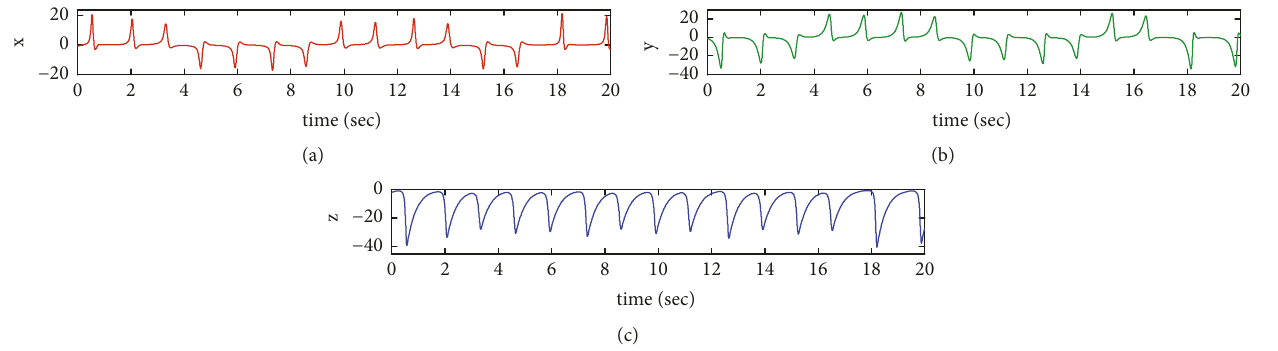
Figure 2: Time evolution of states of Xian system for first 20 seconds: (a) state 𝑥 , (b) state 𝑦 , and (c) state 𝑧